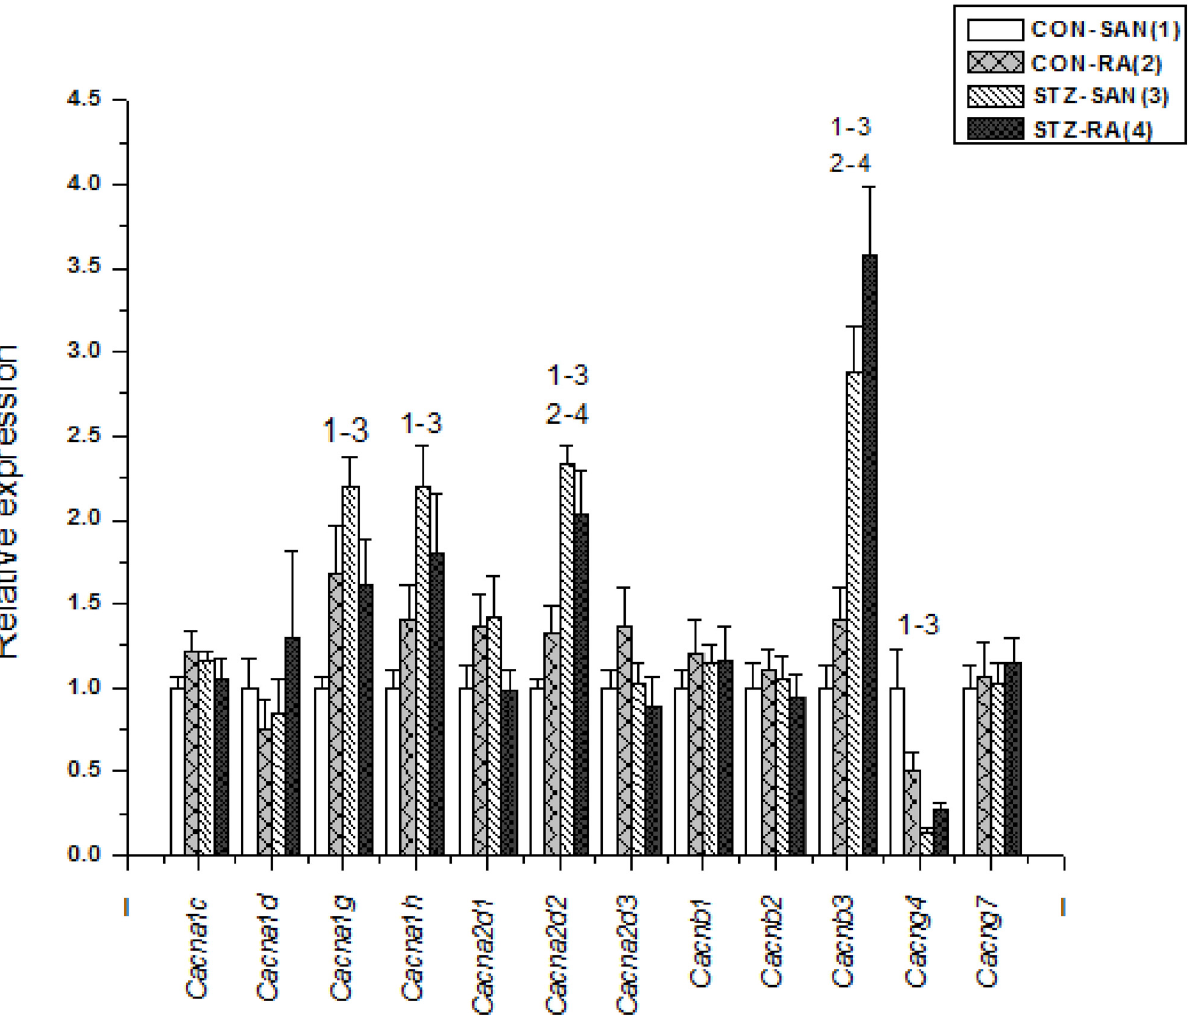
Fig 7. Expression of genes encoding various calcium channel proteins. Data are mean ± SEM, n = 5 – 10 samples from STZ and control rat each containing SANs from 2